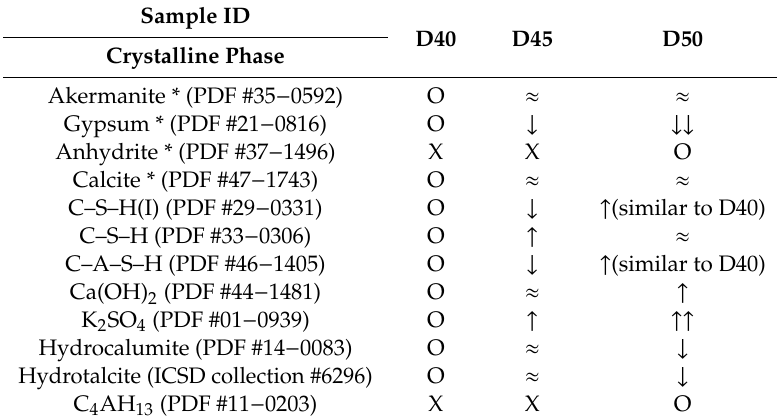
Figure 6. XRD patterns of deionized water-mixed AAS pastes with di ff erent a / b ratios. Table 5. Phase change in the XRD pattern in Figure